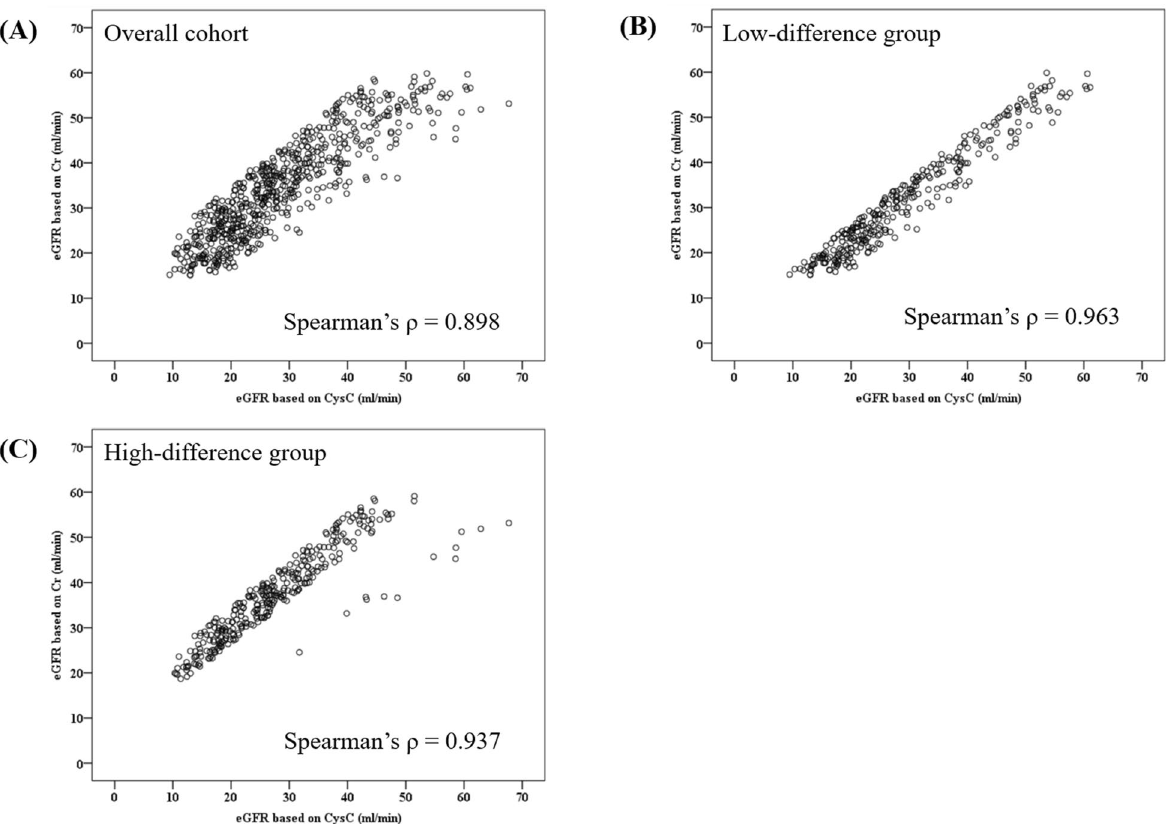
Figure 2. Scatter plot and correlation analysis of eGFR Cr and eGFR CysC . Panels ( A ), ( B ), and ( C ) show the scatter plots of the overall cohort, low-difference group, and high-difference group. The Spearman’s correlation coefficient is noted on each scatter plot. eGFR, estimated glomerular filtration rate; eGFR Cr , eGFR based on creatinine; eGFR CysC , eGFR based on cystatin C.